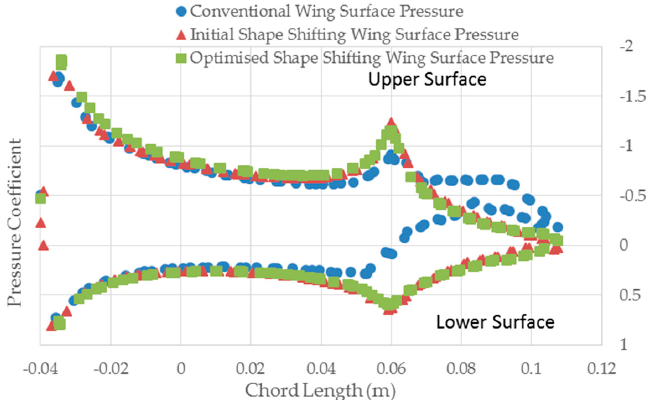
Figure 26. A graph showing the pressure distribution along each wing at the location where vortices are generated on the flap at 5 degrees’ angle of attack.